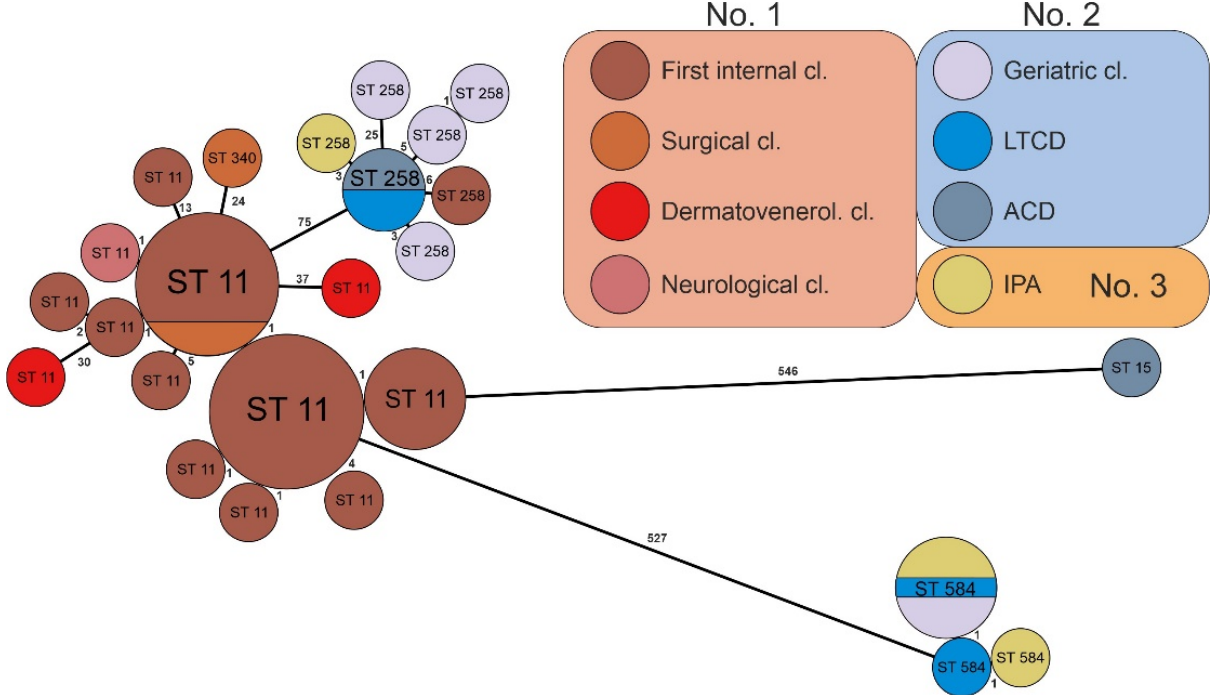
Figure 1. GrapeTree of 41 isolated CR Klebsiella pneumoniae strains based on cgMLST. Ring sizes correspond to the number of strains with the same genotype; the sequence types (STs) of the strains are marked inside the ring. The numbers on lines between rings correspond to the numbers of different alleles between groups. The color code depicts the origin of the strains—clinics, departments, or institutes, as well as the medical setting, labelled with the hospital number ( No. 1 , No. 2 , or No. 3) —including clonal relatedness. Abbreviations: cl. —clinic; Dermatovenerol. cl. —dermatovener-